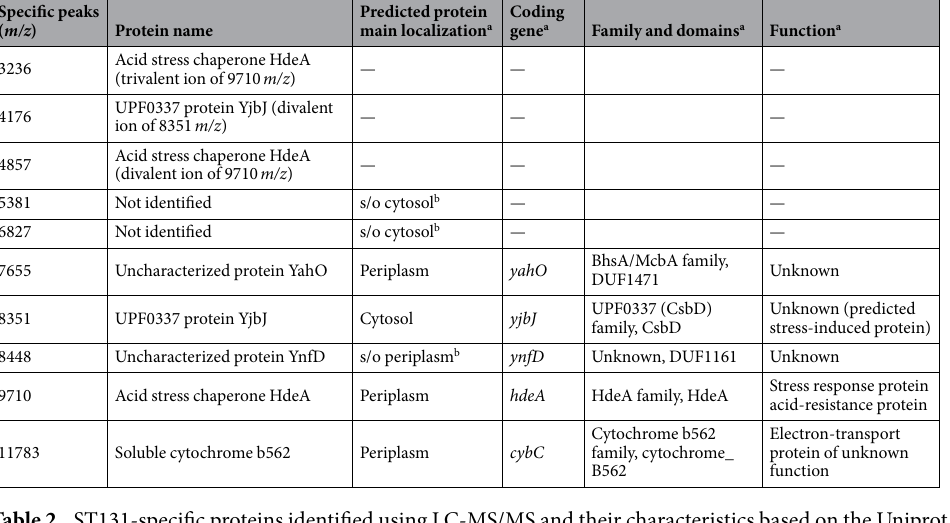
Table 2. ST131-specific proteins identified using LC-MS/MS and their characteristics based on the Uniprot database. a The proteins were investigated for protein name, localization, coding gene, family and domain, and currently known function using the Uniprot database (http://www.uniprot.org). b Unknown due to protein unidentified or not registered in the Uniprot database. Estimated from the fraction from which the proteins were extracted in this